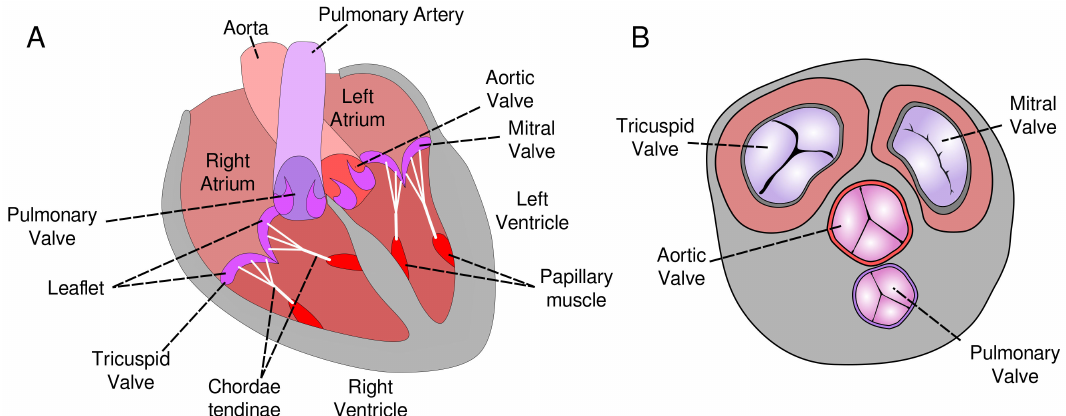
Figure 1. Illustration of the human heart valves. The leaflet of the MV and TV is held in position by CT that extend into the PM, which attach on to the wall of the heart. ( A ) Lateral (frontal) cross-section, ( B ) Transverse